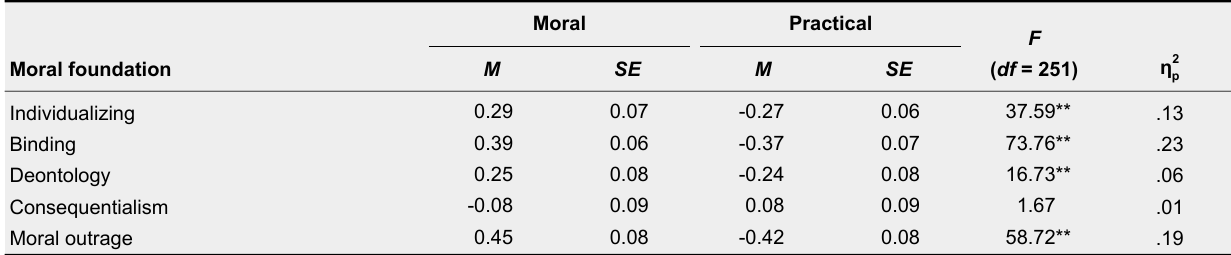
Means and SEs for All Dictionary Scores as a Function of Condition (Moral Versus Practical), Controlling for Initial Stance and Political Orientation in Study 1